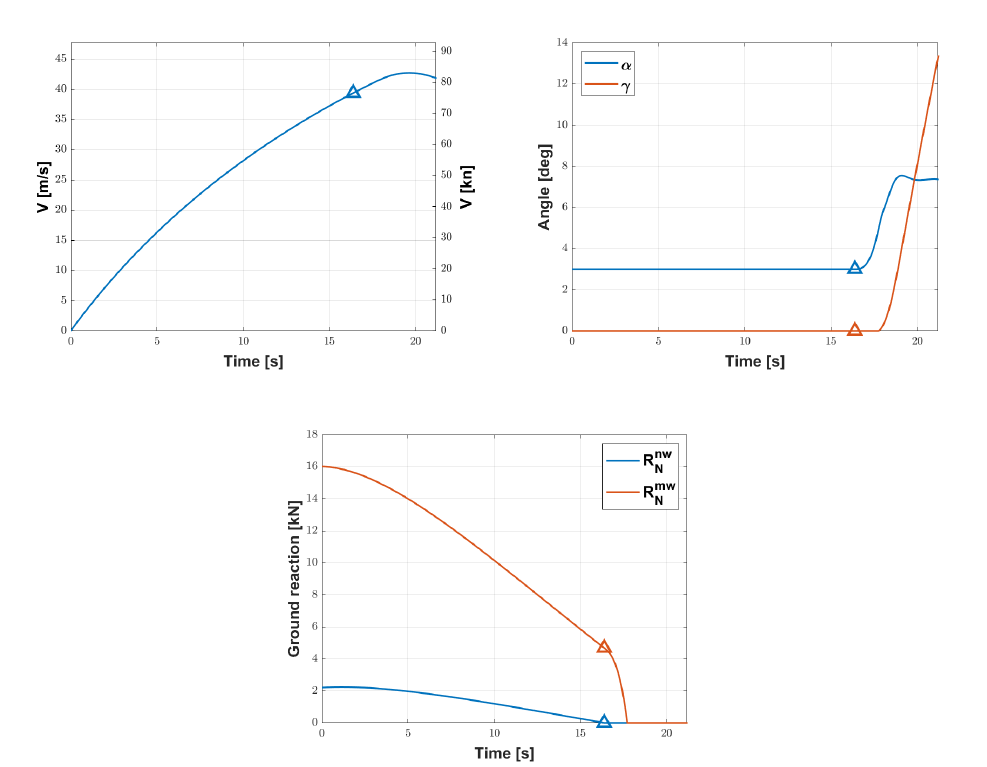
Figure 8. Time histories of airspeed ( top-left ), angle of attack and climb angle ( top-right ), and ground reactions ( bottom ) for an optimal take-off run on the two-surface aircraft. Triangle markers indicate values associated to time instant t 1 .